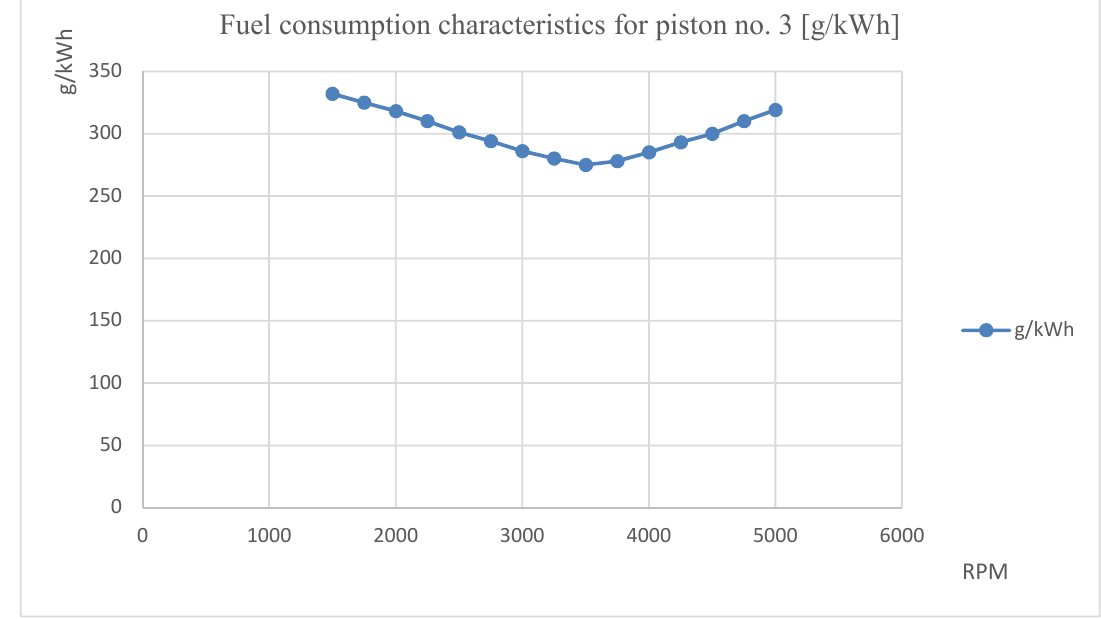
Figure 24. Fuel consumption characteristics for piston no. 3. Table 3. Comparison of engine characteristics using different pistons.